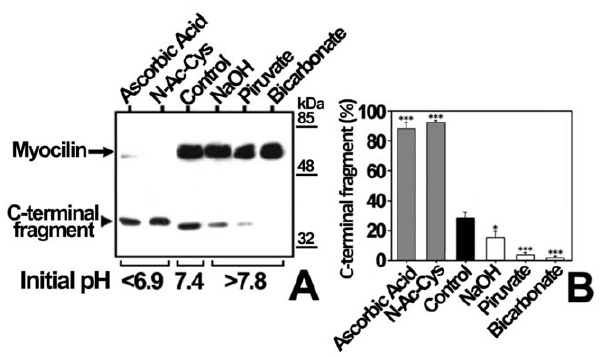
bicarbonate-buffered medium. (A) HEK-293T cells (500000 cells/ plate) were transfected with a cDNA construct encoding myocilin-myc. After transfection, cells were cultured in bicarbonate-buffered medium at different pH values adjusted with the compounds indicated over each lane. Culture media were collected 48 h later and the extracellular recombinant myocilin was analyzed by 10% polyacrylamide SDS-PAGE and Western blot using an anti-myc monoclonal antibody. Equal amount of total protein was loaded into each well. (B) Quantitation by densitometry of the C-terminal fragment detected in A. Values represent the proportion of this myocilin fragment, expressed as indicated in Fig. 1B. Error bars correspond to the SD of three independent experiments carried out in triplicate. Asterisks indicate statistical significance compared to control: p , 0.05 (*); p , 0.01 (**); p , 0.001 (***). One-way ANOVA followed by Tukey multiple-comparison test.